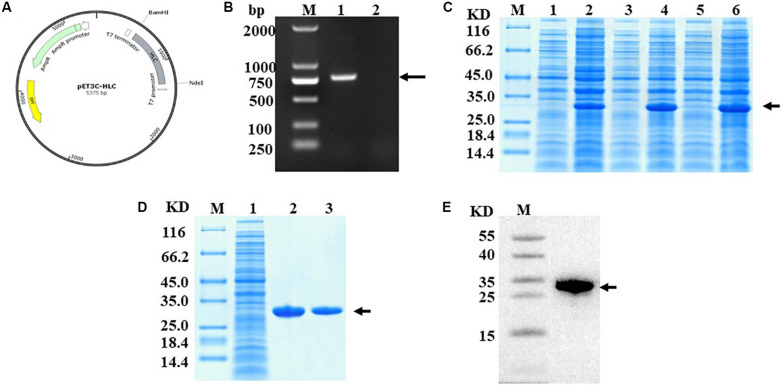
Construction and identification of RHC. (A) Construction schematic of the recombinant pET3c-hlcollagen plasmid. (B) Nucleic acid electrophoresis of recombinant plasmid pET3C-HLC. M: DNA Ladder 2000; lane 1: monoclone of recombinant plasmid pET3C-HLC; lane 2: negative control. (C) Effect of temperature on RHC expression, as analyzed by SDS-PAGE. Recombinant human-like collagen was induced by IPTG for 4 h at either 37 or 30°C or overnight at 20°C. M: middle molecular weight protein markers; lanes 2, 4, and 6: RHC after induction at 20, 30, or 37°C; lanes 1, 3, and 5: RHC before induction. (D) Sodium dodecyl sulfate–PAGE analysis of proteins during purification. M: middle molecular weight protein markers; lane 1: broken by PBS; lane 2: Ni-NTA spin columns; lane 3: washed protein through 80 mM imidazole. (E) Western blotting analysis. M: middle molecular weight protein markers; lane 1: RHC with an anti-His antibody.